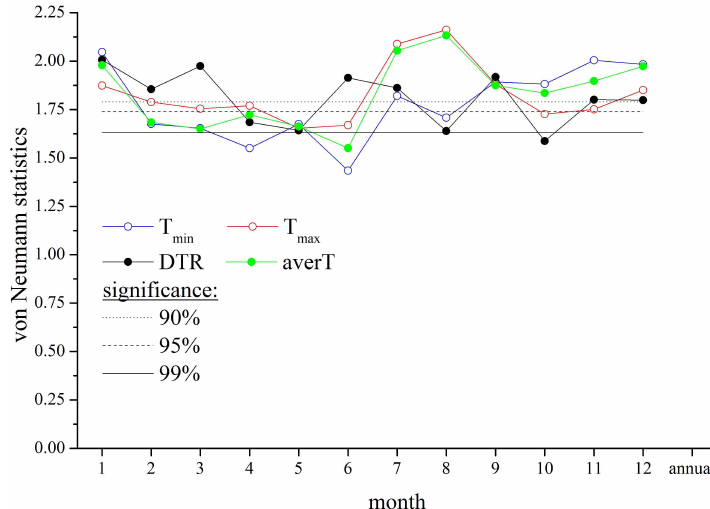
Figure 24. Coimbra: same as Fig. 20 but for the corrected series.